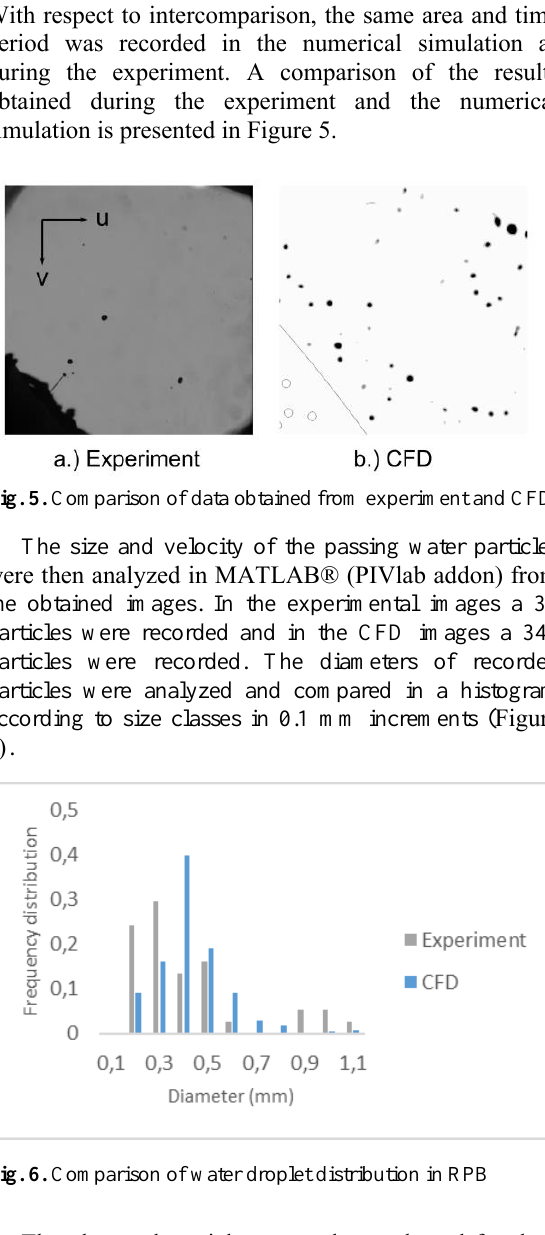
direction of the individual components (see Fig. 4 )